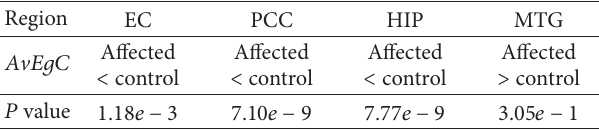
Table 7: Comparison of mean eigenvector centrality scores ( 𝐴 V 𝐸𝑔𝐶 ) of low TO genes in control and affected coexpression networks per region. Region EC PCC HIP MTG Affected Affected Affected 𝐴 V 𝐸𝑔𝐶 Affected < control < control < control > control 𝑃 value 1.18𝑒 − 3 7.10𝑒 − 9 7.77𝑒 − 9 3.05𝑒 − 1